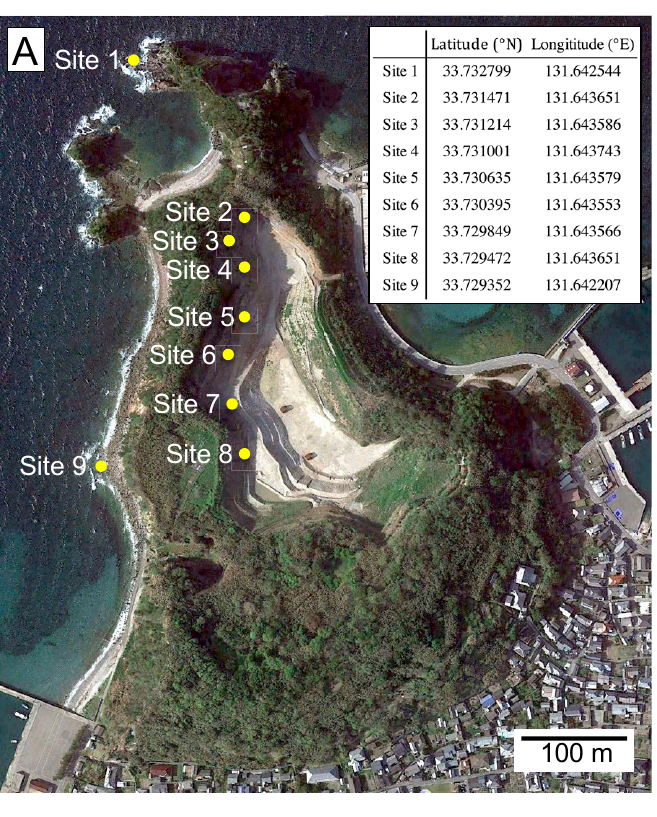
Figure 15: [A] Map indicates the sampling sites for density measurements (sites 1–9), FTIR analyses (sites 1, 2, 6, and 9), and anisotropy of magnetic susceptibility measurements (sites 2, 5, 6, 8, and 9). [B] Results of the density measure- ments. The vesicularity is also attached. [C] Results of the FTIR